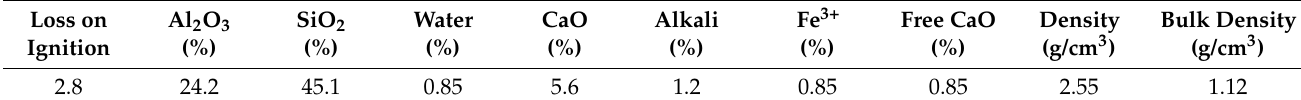
Table 1. The chemical constituents of fly ash.